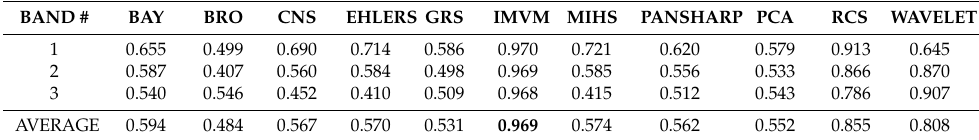
Table 2. Spectral consistency: correlation coe ffi cient (CC).